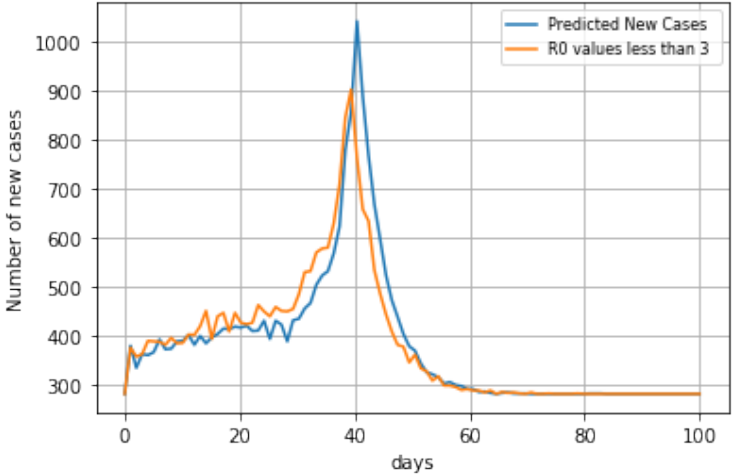
Figure 11. Predicted New Cases with smaller. R 0